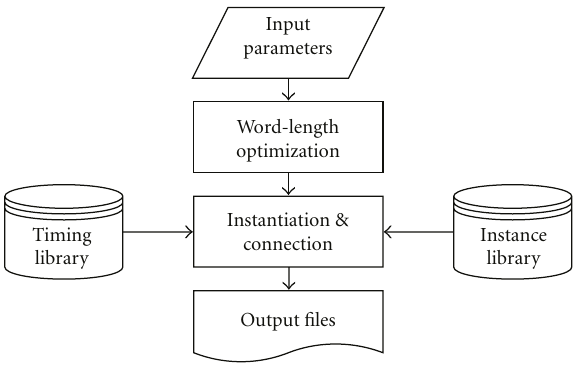
Figure 9: Flowchart of the proposed IP generator.